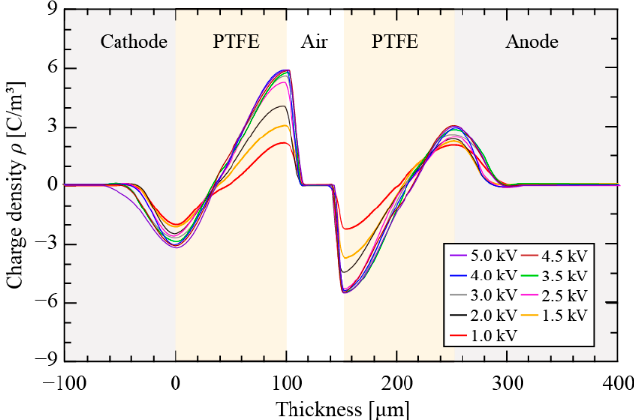
Figure 7. Measured space charge distribution of cellular PTFE electrets. The measured surface charge density ( σ PEA ) at the air–PTFE interface was derived from the integral of the PEA-measured space charge density, ρ ( x ), at the interface region [38]. Figure 8a depicts σ below the poling voltages V DC . For a charging time of 20 min, the soft X-ray-charged specimen (circles on solid lines) exhibited an approximately linear increase in σ PEA , and eventually a maximum ( σ max = ~0.18 mC/m 2 ) was observed when V DC was over 3 kV. Compared with the DBD charging ( σ DBD-model , blue dotted line), soft X-ray based cellular electret charging technology was able to generate high-density plasma and enabled higher surface charge densities at the air–PTFE interface, which typically exceeded several times the value in DBD-based charging when V DC < 2 V DBD . Although both σ PEA and σ DBD-model can eventually achieve the same σ max , the critical poling voltage ( V DC ) required to reach σ max in soft X-ray was 1.3 V DBD , which meant the soft X-ray charging required a much lower V DC to achieve charging